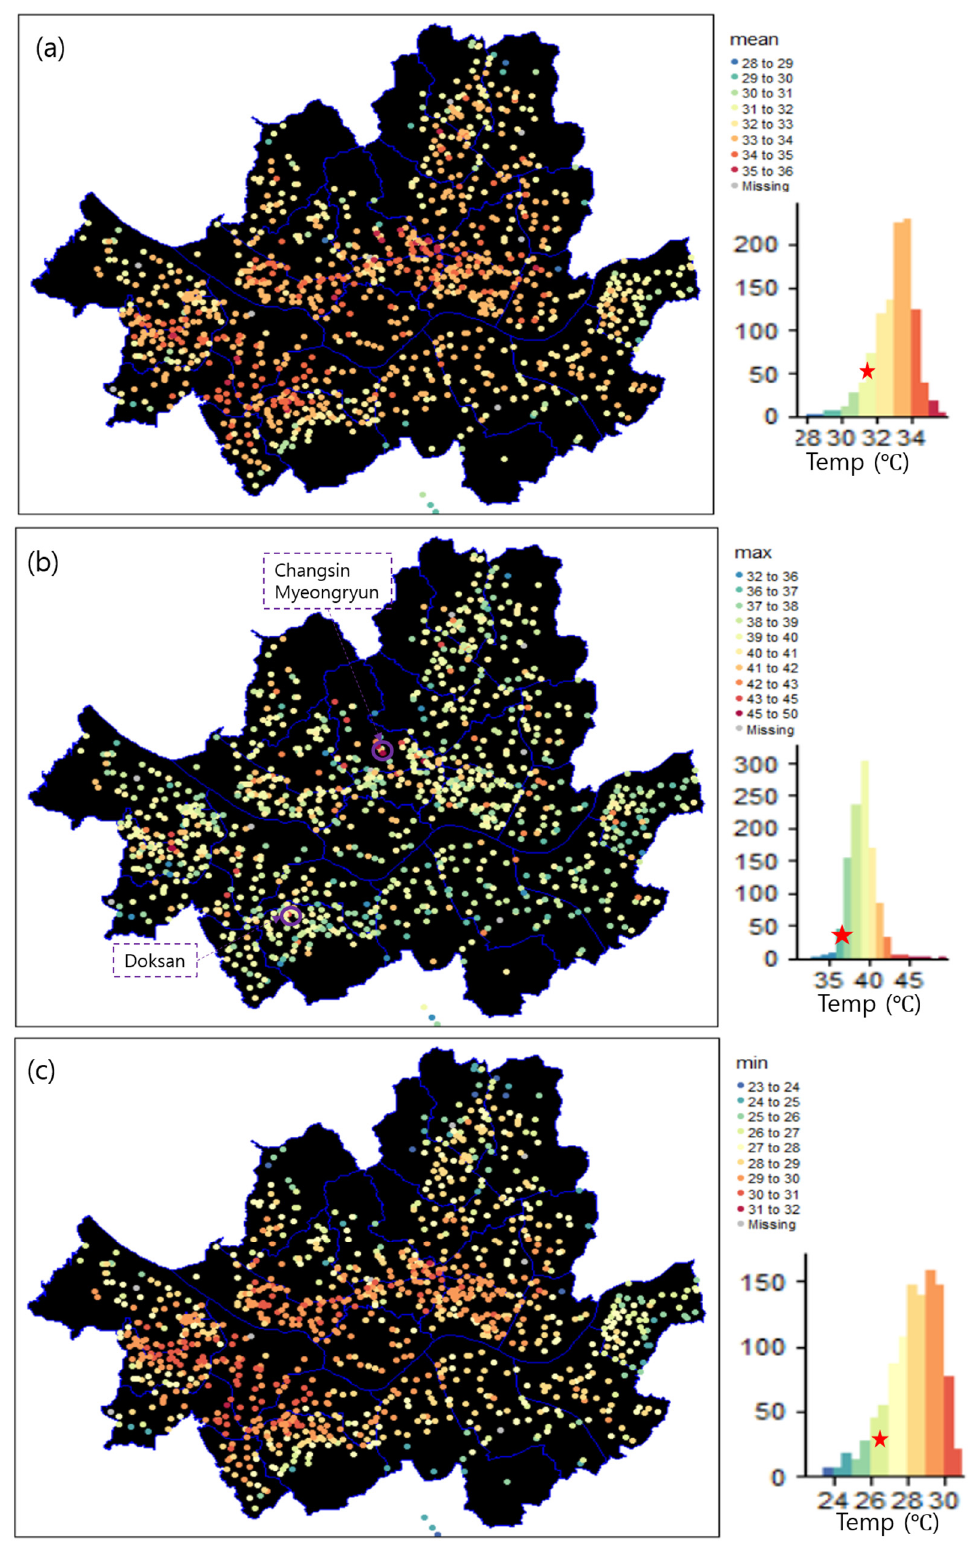
Figure 2. Horizontal distribution of daily ( a ) mean, ( b ) maximum, and ( c ) minimum temperatures on 24 July 2021, obtained by the S-DoT IoT meteorological sensors. The occurrence frequency for temperature is shown in the right bottom histogram. The values observed by Seoul ASOS are indicated by a red star.